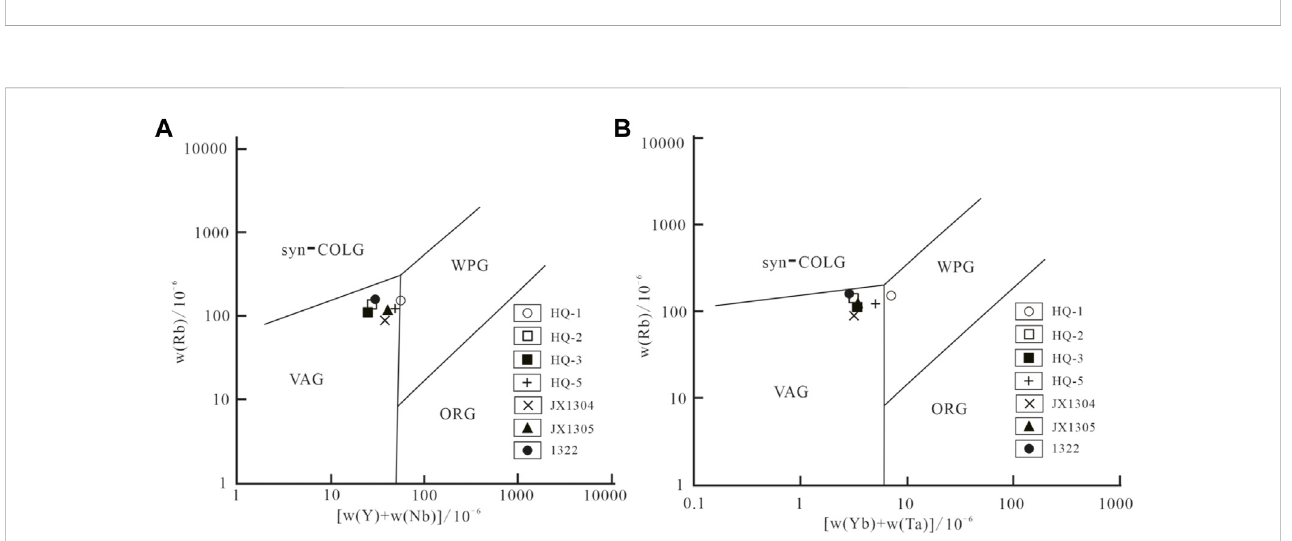
FIGURE 12 Nb-Y (A) and Rb-(Yb+Ta) (B) tectonic discrimination diagrams of granites in the Xinchenggou area, Dongning County (after Pearce et al., 1984). Abbreviations: syn-COLG = syn-collisional granite; VAG = volcanic arc granite; WPG = within-plate granite; ORG = ocean ridge granite.